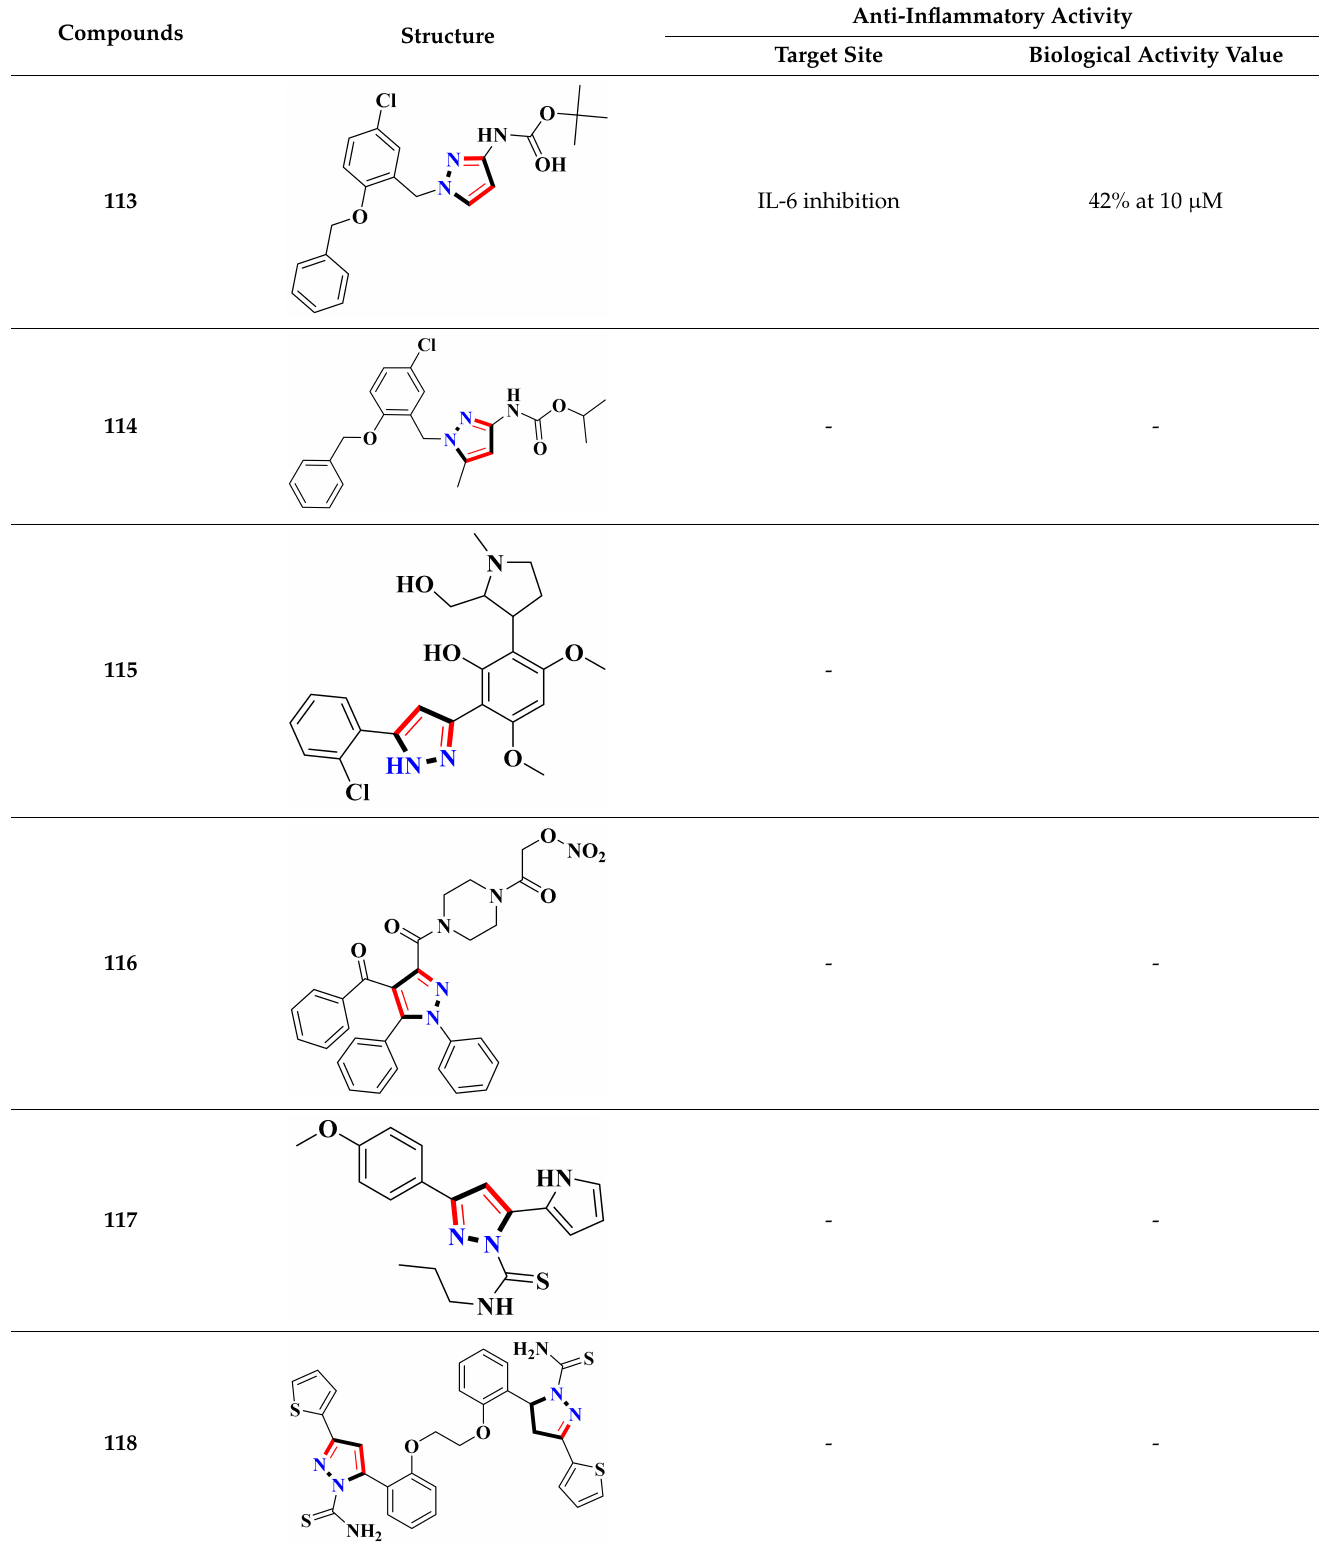
Table 9. Representative compound structures 113 to 129 and their anti-inflammatory